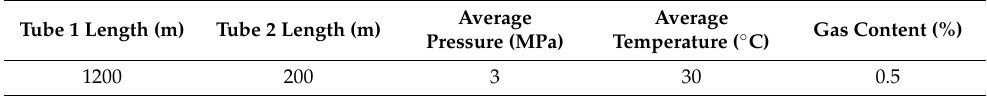
Table 1. Two-layer stratified water injection test conditions.